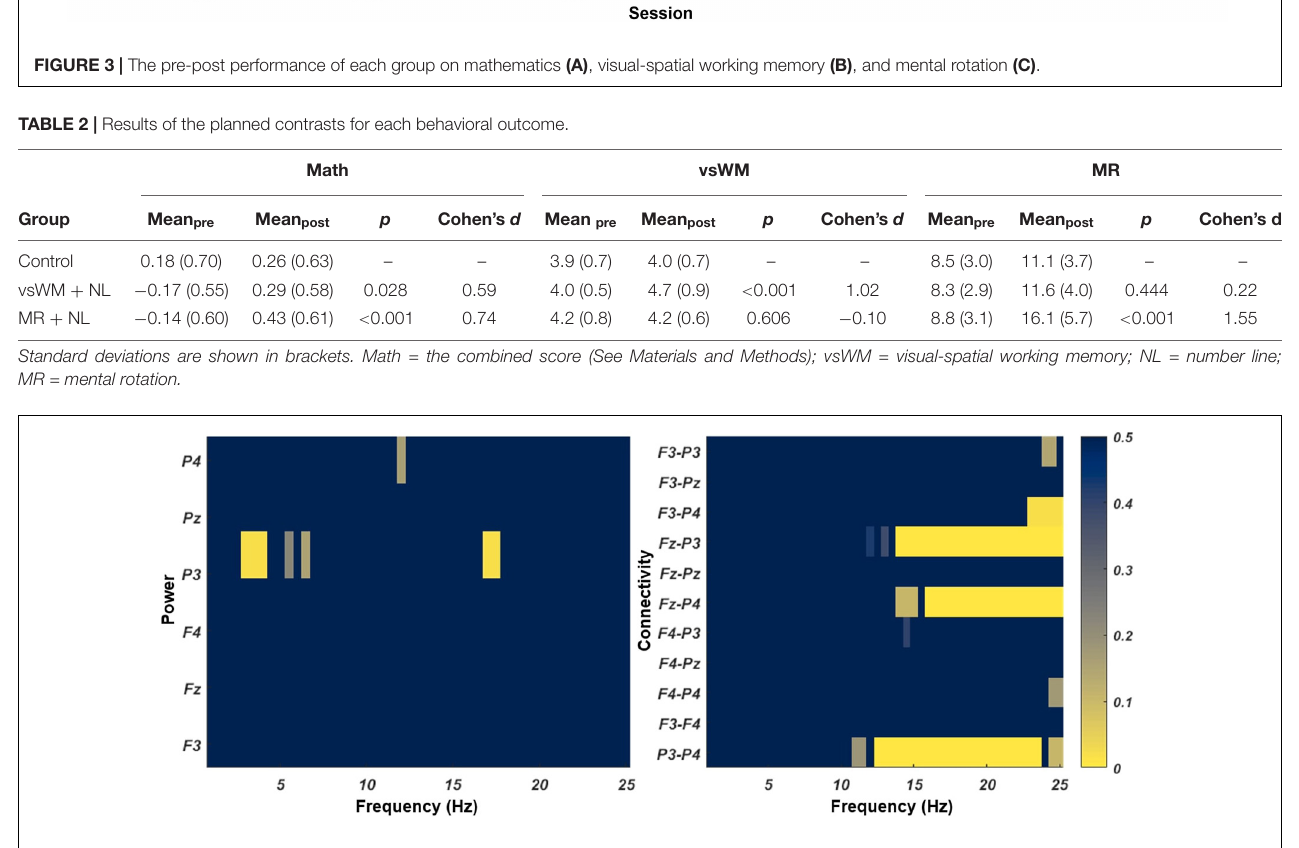
FIGURE 4 | The rs-EEG clusters of spectral power and connectivity showed the Session effect. The color bar refers to the cluster-level p -values.